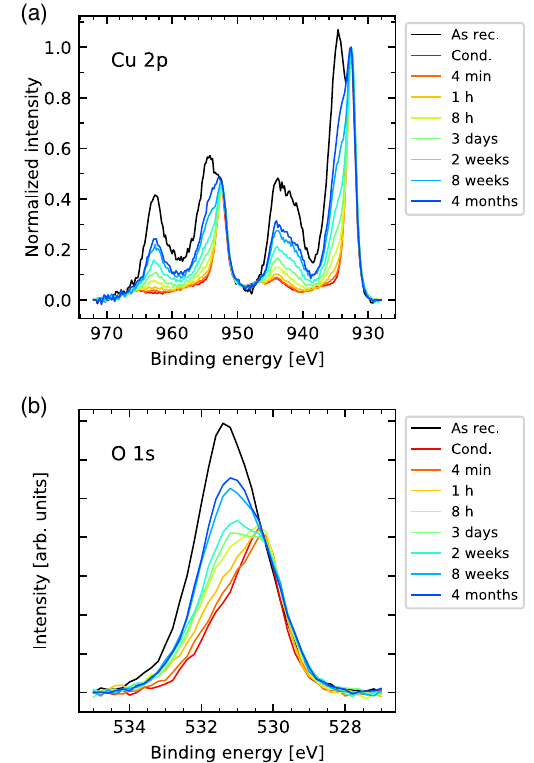
FIG. 3. X-ray photoelectron spectra of an OFE copper sample in the as received and fully conditioned states and after different storage times in a desiccator: (a) Cu 2p lines (normalization to the intensity at 932.6 eV after linear background subtraction) and (b) corresponding O 1s lines, after Shirley background subtraction.